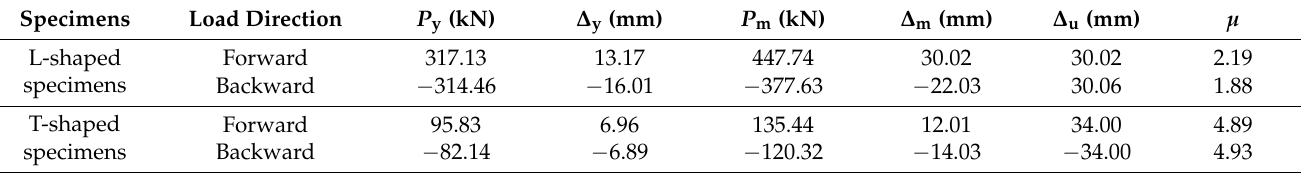
Table 2. Mechanical properties of the